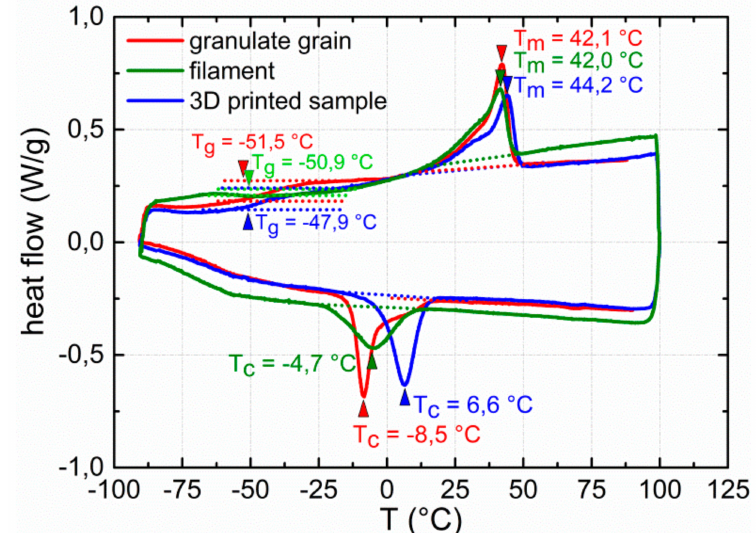
Figure 8. DSC thermograms of PEU: Thermal behavior of a granulate grain (red color), a piece of filament (green color) and a sample from the substrate of a type 2 QR code carrier as obtained via FFF (blue color). The thermograms are exhibited for the second heating and cooling. The individual enthalpies of melting are 25.9 J · g − 1 (granulate grain), 21.1 J · g − 1 (filament) and 25.1 J · g − 1 (3D printed sample), the enthalpies of crystallization are − 25.7 J · g − 1 (granulate grain), − 21.0 J · g − 1 (filament), and − 25.0 J · g − 1 (3D printed